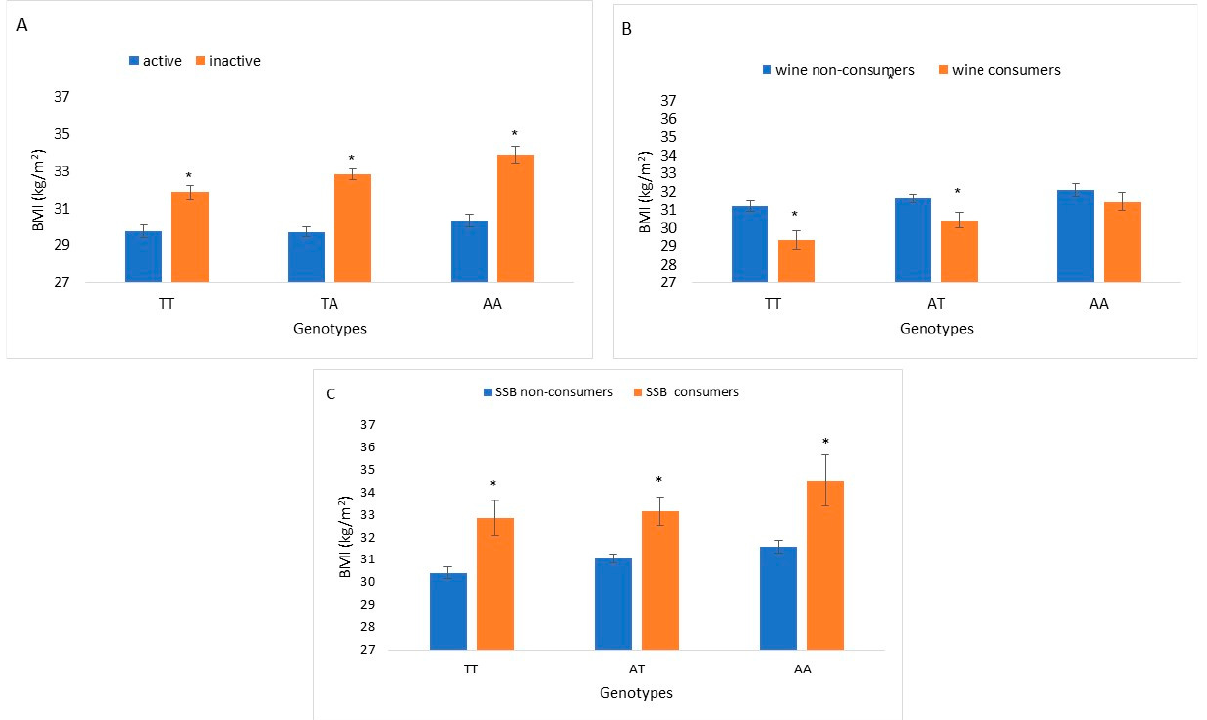
Figure 1. BMI increments of FTO rs9939609 genotypes interaction with actionable environmental factors: physical activity ( n = 1735), wine consumption ( n = 1754) and SSB consumption ( n = 1796). ( A ): BMI of physical activity stratified by FTO rs9939609 genotypes. Bars indicate BMI levels of active and inactive FTO rs9939609 wild type (TT), heterozygous (TA) and homozygous (AA). ( B ): BMI of wine consumption stratified by FTO rs9939609 genotypes. Bars indicate BMI levels of participants consuming 1–3 drinks/week and non-wine consumers among FTO rs9939609 genotypes. ( C ): BMI of SSBs ( ≥ 1 serving/day) consumption stratified by FTO rs9939609 genotypes. Bars indicate BMI levels of participants consuming ≥ 1 serving of SSB/day and non-SSB consumers among FTO rs9939609 genotypes. Differences between BMI levels within each genotype group (TT, TA and AA) were tested by Mann–Whitney for 2 independent samples. Asterisks represent statistically significant difference p <